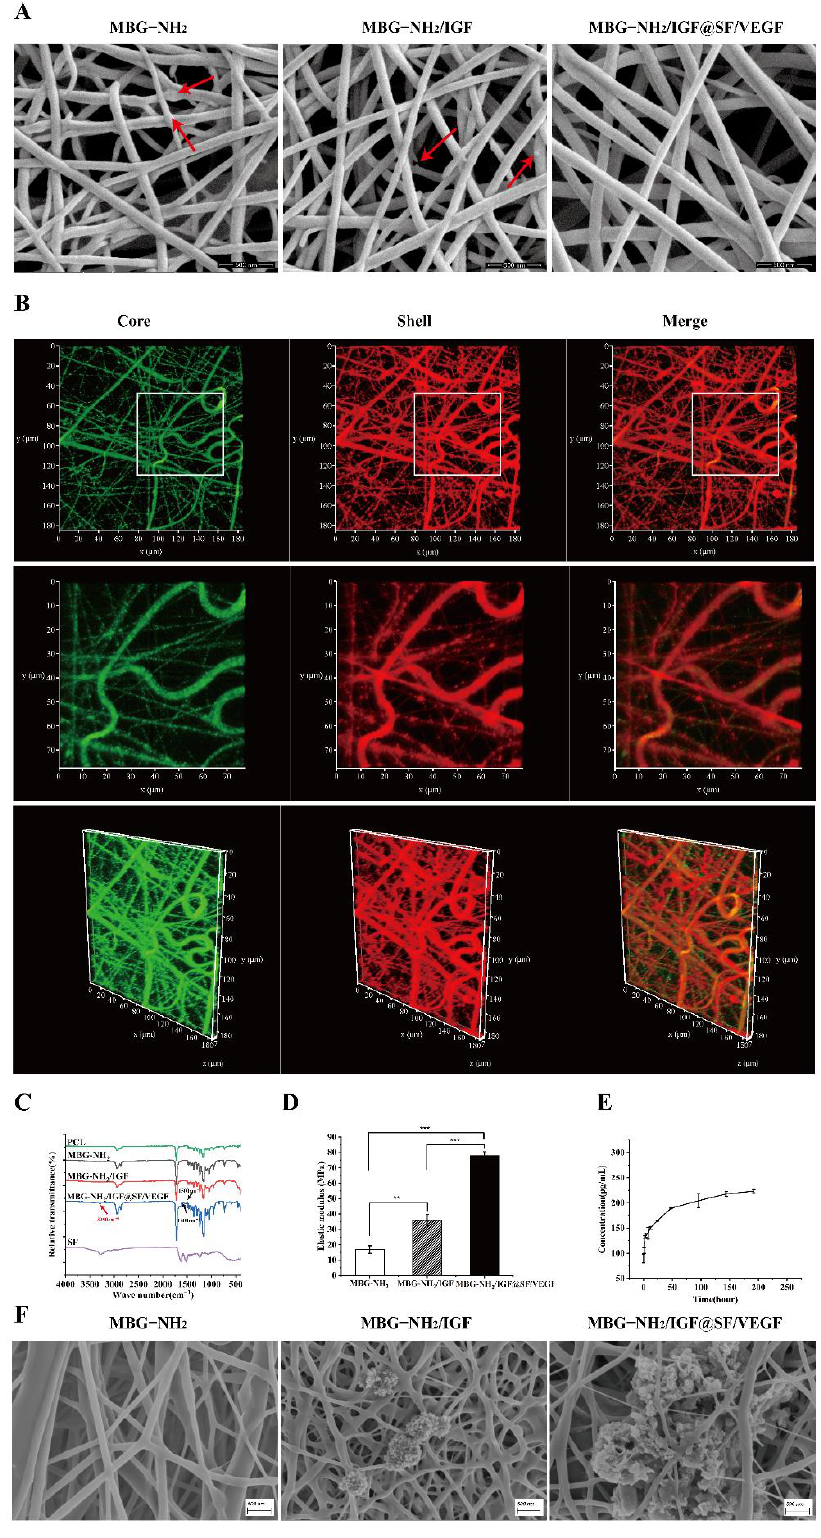
Figure 1. Characteristics of scaffolds. ( A ) SEM images of MBG-NH 2 , MBG-NH 2 /IGF and MBG- NH 2 /IGF@SF/VEGF scaffolds. Scale bars: 500 nm. The red arrows indicate the MBG particles. ( B ) The CLSM images of MBG-NH 2 , MBG-NH 2 /IGF and MBG-NH 2 /IGF@SF/VEGF scaffolds. Images (the second line) were enlarged from the square frame in the images (the first line), and images